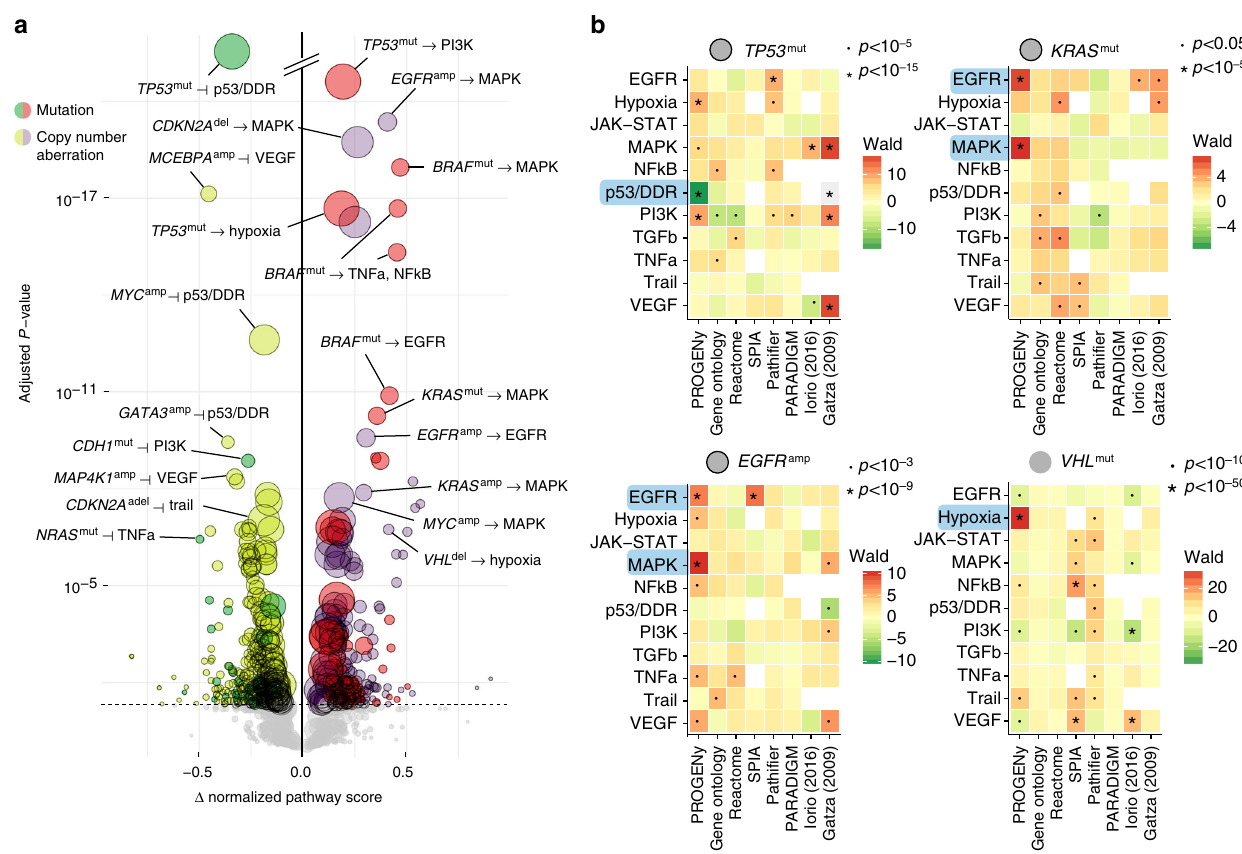
Fig. 3 Ability of pathway methods to recover well-known mutations. a Volcano plot of pan-cancer associations between driver mutations and copy number aberrations with differences in pathway score. Pathway scores calculated from basal gene expression in the TCGA for primary tumors. Size of points corresponds to occurrence of aberration. Type of aberration is indicated by superscript “ mut ” if mutated and “ amp ” / ” del ” if ampli fi ed or deleted, with colors as indicated. Effect sizes on the horizontal axis larger than zero indicate pathway activation and smaller than zero indicate inferred inhibition. P values on the vertical axis FDR-adjusted with a signi fi cance threshold of 5%. Associations shown without correcting for different cancer types. Associations with a black outer ring are also signi fi cant if corrected. b Comparison of pathway scores (vertical axes) across different methods (horizontal axes) for TP53 and KRAS mutations, EGFR ampli fi cations and VHL mutations. Wald statistic shown as shades of green for downregulated and red for upregulated pathways. P value labels shown as indicated. White squares where a pathway was not available for a